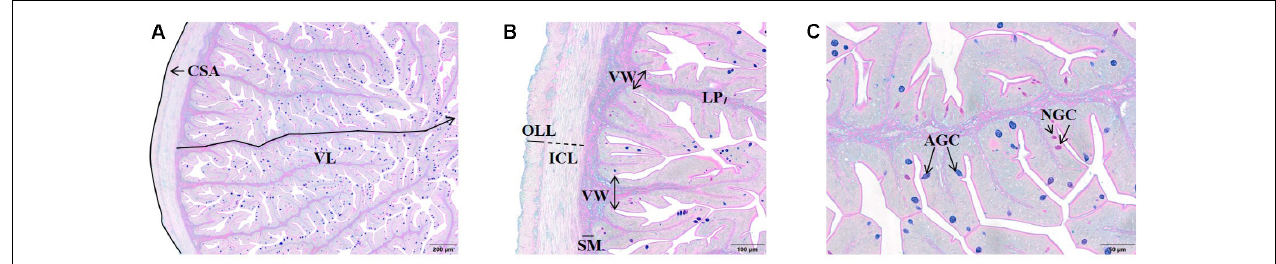
FIGURE 1 | Histological sections (Alcian blue/PAS staining, pH = 2.5) of the anterior intestine of European sea bass. (A) CSA, cross-sectional area, VL, villus length (40 × ). (B) ICL, inner circular layer, LP, lamina propria, OLL, outer longitudinal layer, SM, submucosa VL, villus width (100 × ). (C) AGC, acid goblet cell, NGC, neutral goblet cell (200 ×